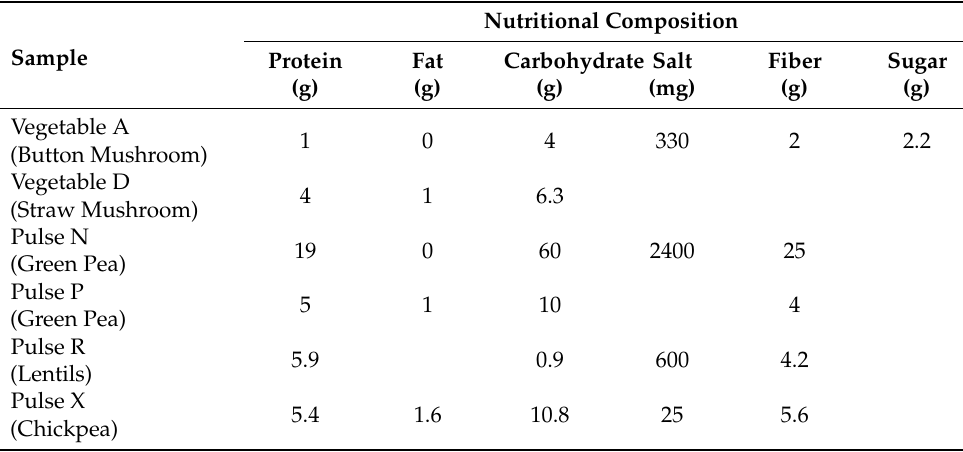
Table 2. Nutritional composition of canned products.